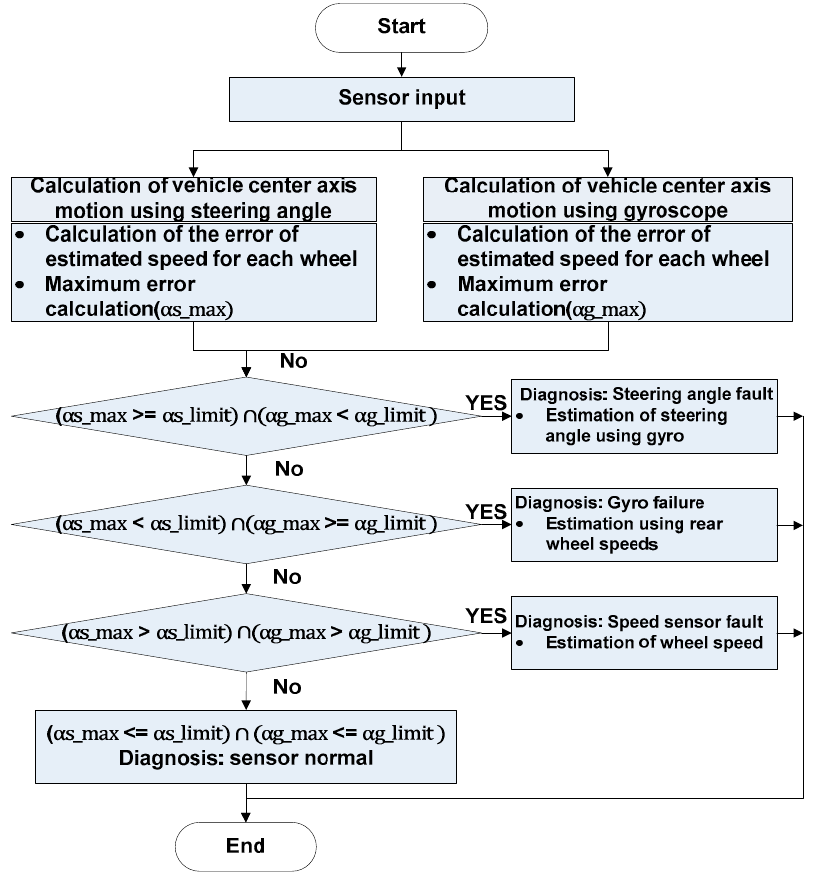
Figure 2. Diagnostic sequence flowchart.